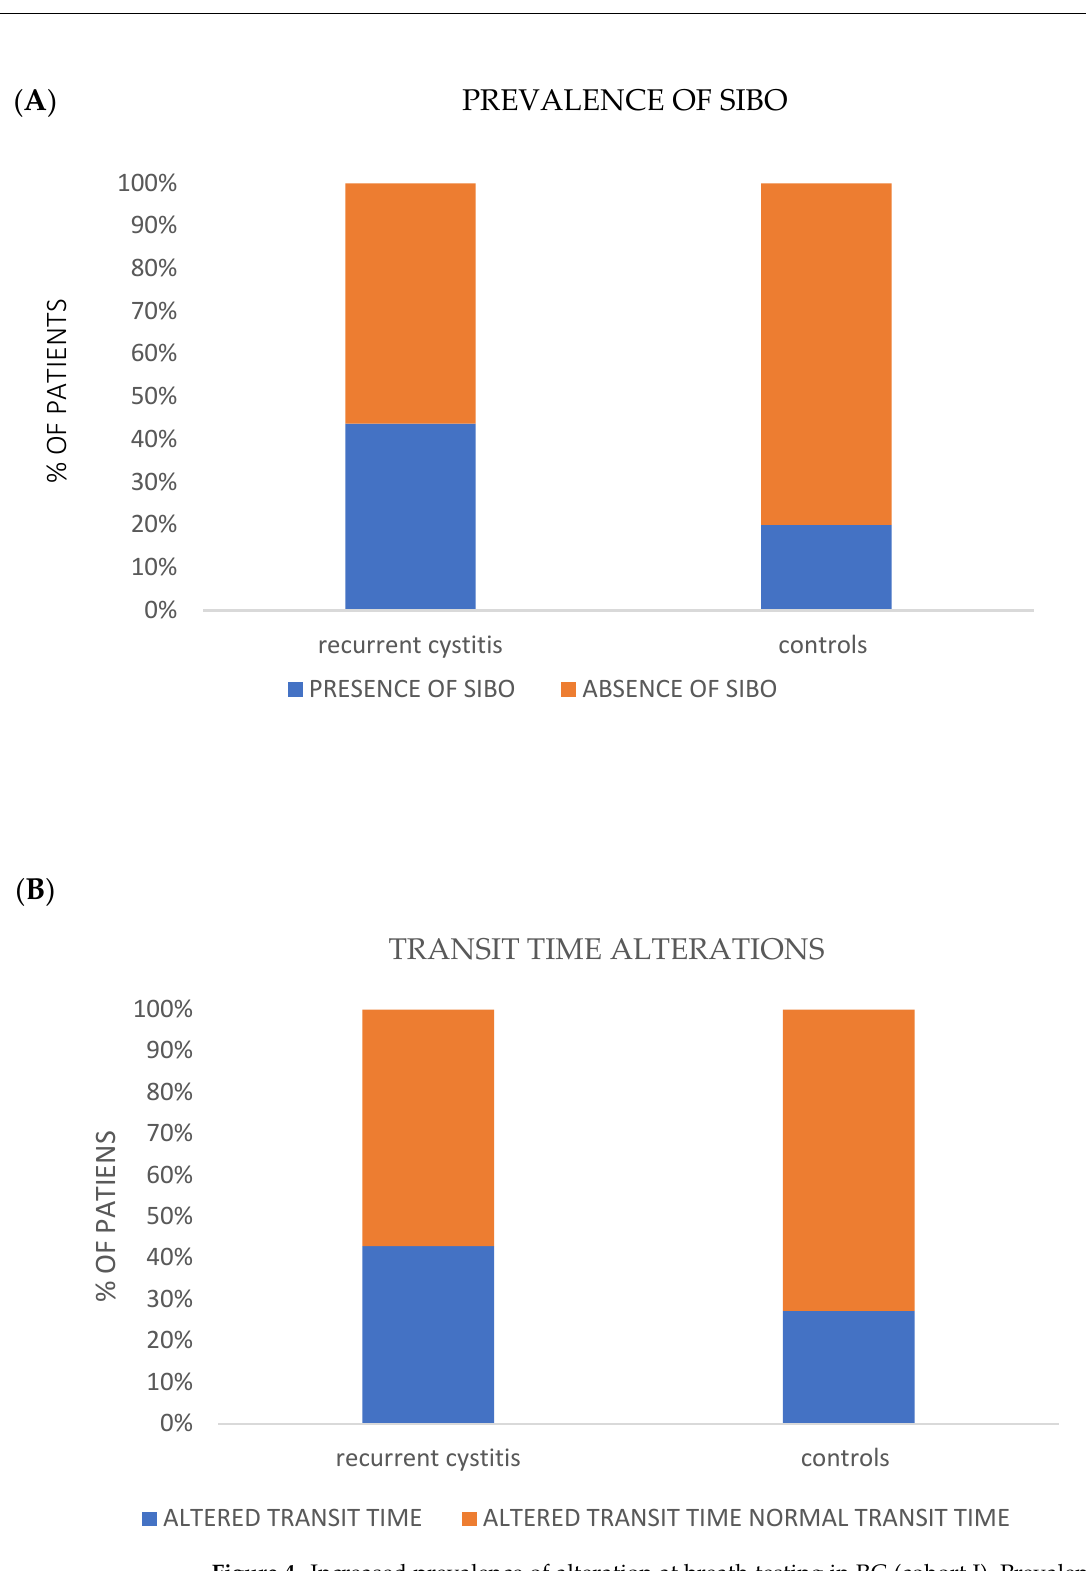
Figure 4. Increased prevalence of alteration at breath testing in RC (cohort I). Prevalence of SIBO ( A ) and prevalence of oro-cecal transit time alterations ( B ). The Breath Test showed that patients with recurrent cystitis showed a trend towards an increased prevalence of SIBO and alterations of the oro-cecal transit time, compared to the control population (differences were not statistically significant, p >